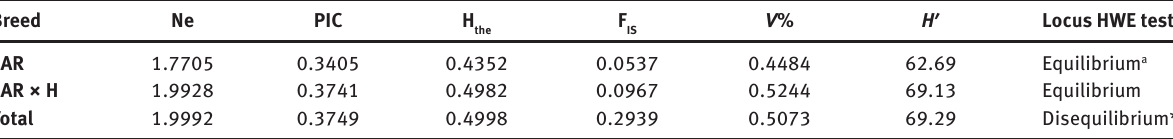
Table 2: Population genetic parameters of the SNP of the bovine FSHB gene